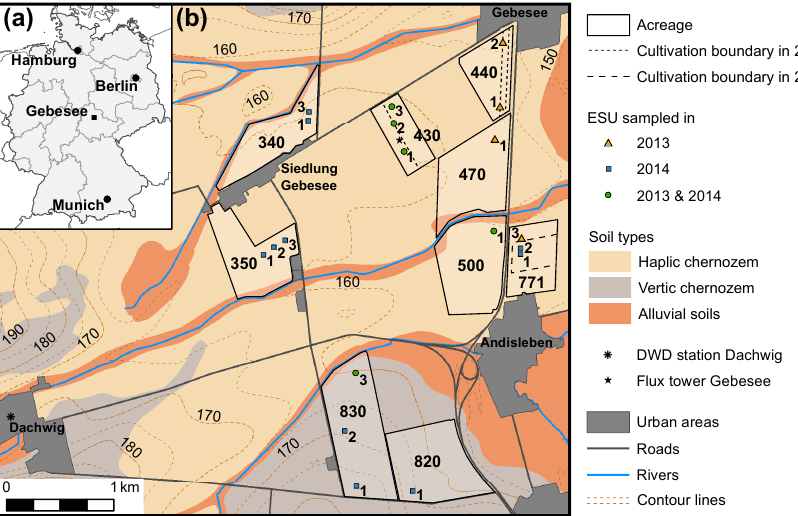
Figure 1. Location of (a) the Gebesee test site within Germany and (b) elementary sampling units (ESUs) on the acreages of the Geratal Agrar GmbH & Co. KG Andisleben. Relief and predominant soil types are shown according to TLVermGeo (2008) and TLUG (2000, 2002), respectively. Urban areas, roads, and rivers were digitalized from TLVA (2003) and TLVermGeo (2006, 2010, 2012). The location and numbering of fields were taken from Döring (1988). Note the eddy covariance flux tower (MPI BGC, 2015) in the center of acreage 430 and the meteorological station of the DWD (Deutscher Wetterdienst; DWD, 2016) in Dachwig in the